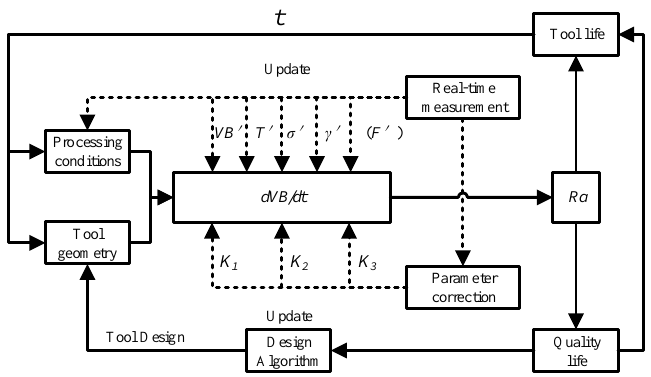
Figure 16. General method of performance design based on the analytical model.